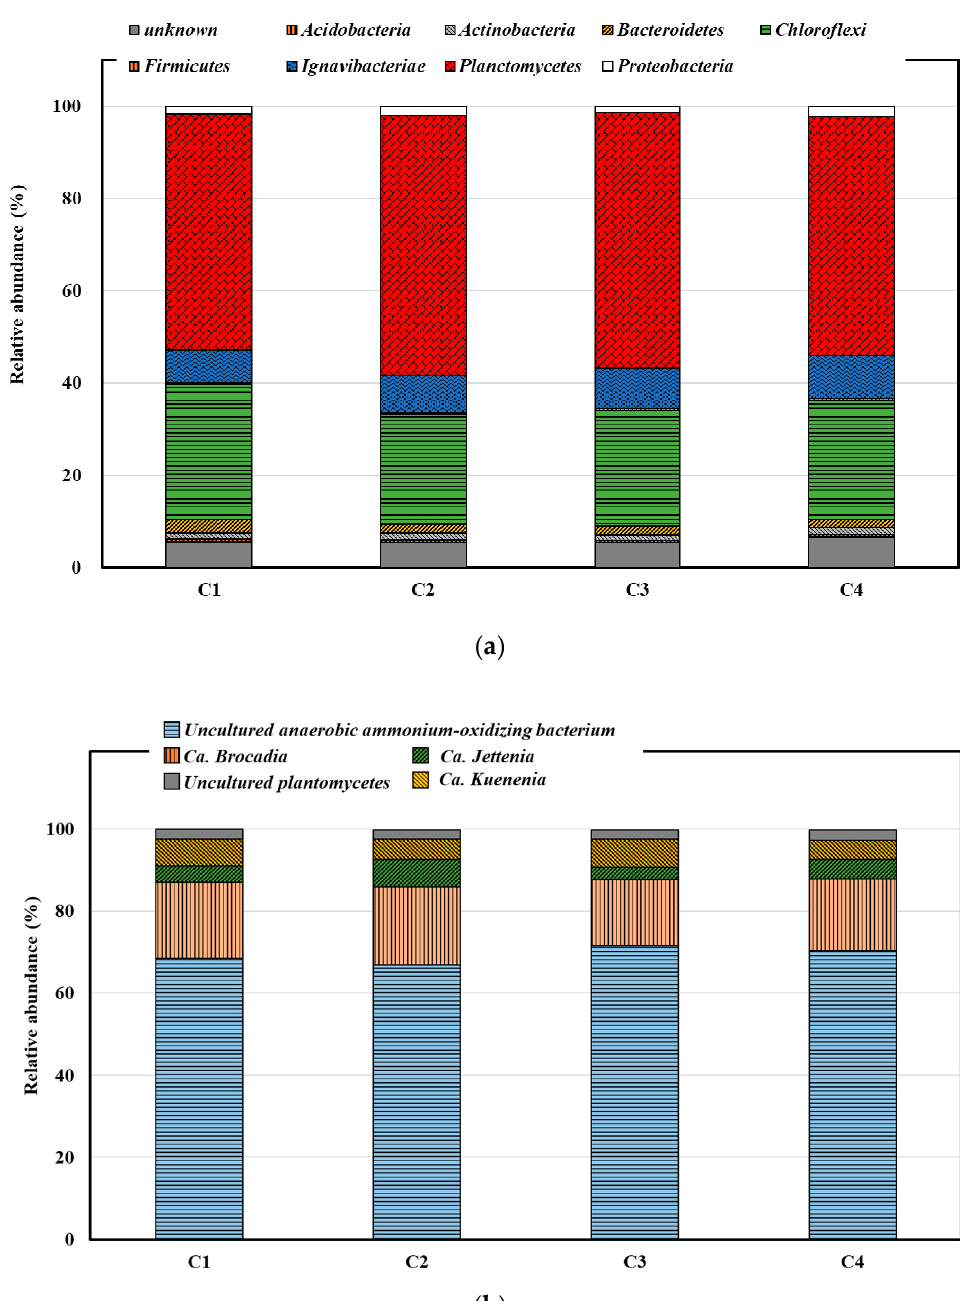
Figure 7. Relative abundances (%) at phylum level ( a ) and at species level on anammox bacteria ( b ); C1 (no salt and no cation), C2 (5 g NaCl/L and no cation), C3 (5 g NaCl/L and 200 mg/L Ca 2+ ), and C4 (5 g NaCl/L and 70 mg/L Mg 2+ ).